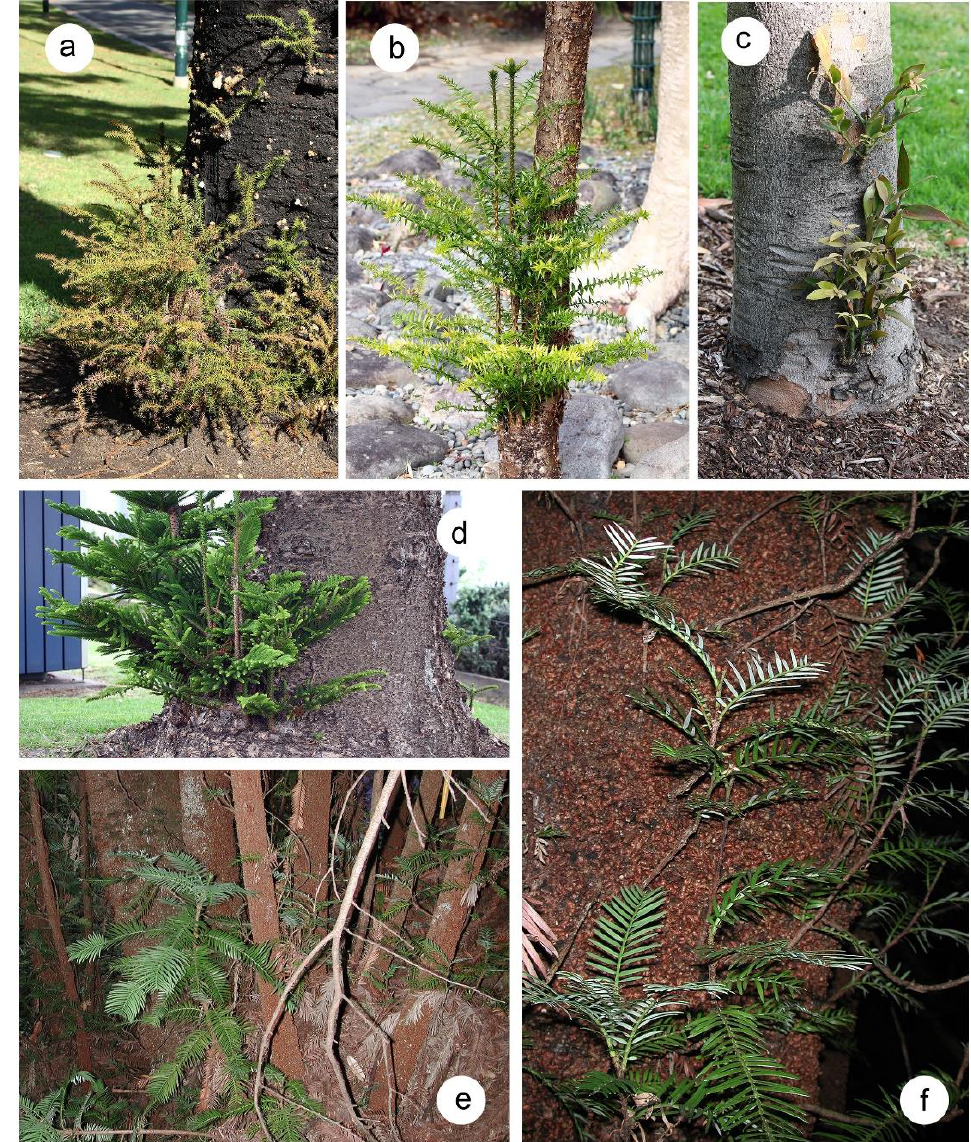
Figure 1. Epicormic and coppice shoots for various species in the Araucariaceae. ( a ) Araucaria cunninghamii , ( b ) Araucaria bidwillii , ( c ) Agathis robusta , ( d ) Araucaria heterophylla , ( e , f ) Wollemia nobilis . In ( a – d ) the shoots had formed on relatively intact specimen trees that may have been subject to damage from landscape maintenance. While different to resprouting after substantial damage it does show that these conifer species retain a resprouting capacity in mature trees. ( e , f ) Wollemia nobilis in the Wollemi National Park. ( e ) clump of coppice shoots from what is possibly a single individual. ( f ) large diameter trunk with numerous epicormic shoots growing from the distinctive bubble bark.